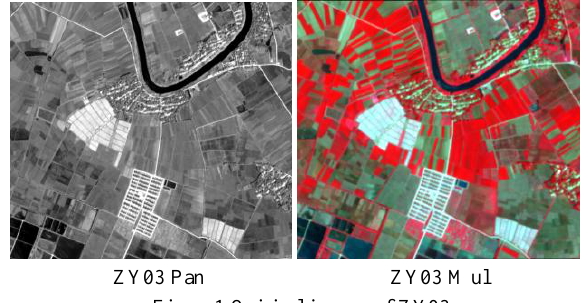
Figure.1 Original images of